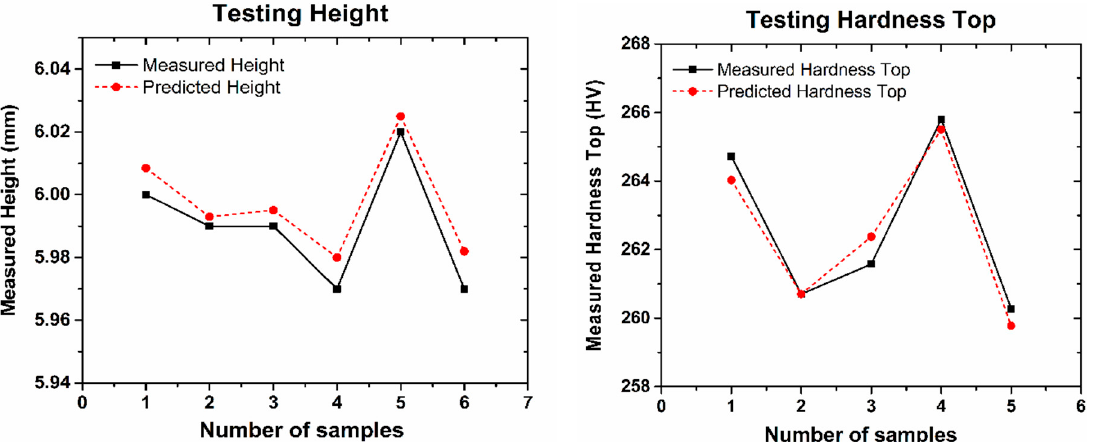
Figure 6. The trends of testing samples for height ( left ) and hardness top ( right